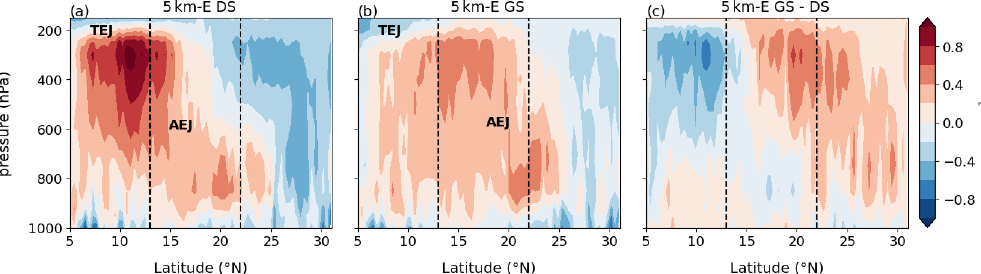
Figure 6. Vertical cross section of the vertical wind component for the 5km-E DS (a) and GS (b) , as well as for the difference between the GS and DS (c simulation, respectively, averaged over the WA domain outlined in Fig. 1. Again, the locations of the African easterly jet (AEJ) and the tropical easterly jet (TEJ) are indicated by the labels. The dashed vertical lines again indicate the latitudes of the coastal, Sahel, and Sahara domain also displayed in Fig.